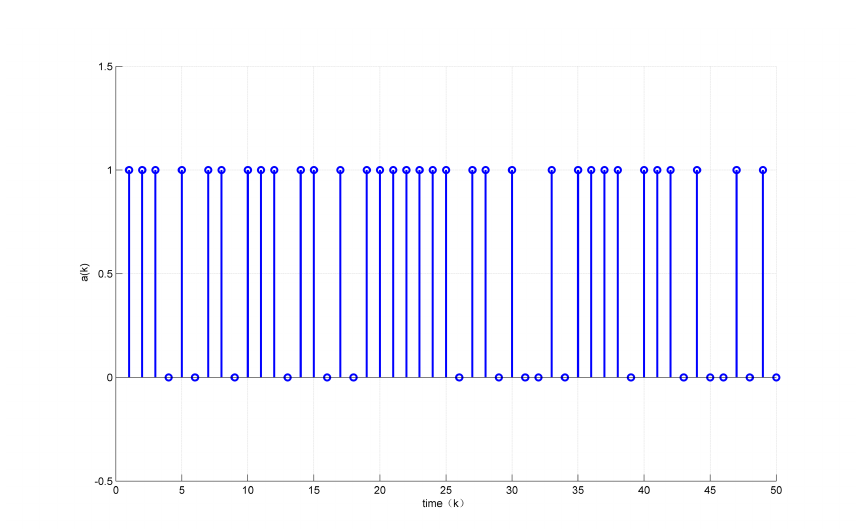
Figure 3. Evolution of state x2.